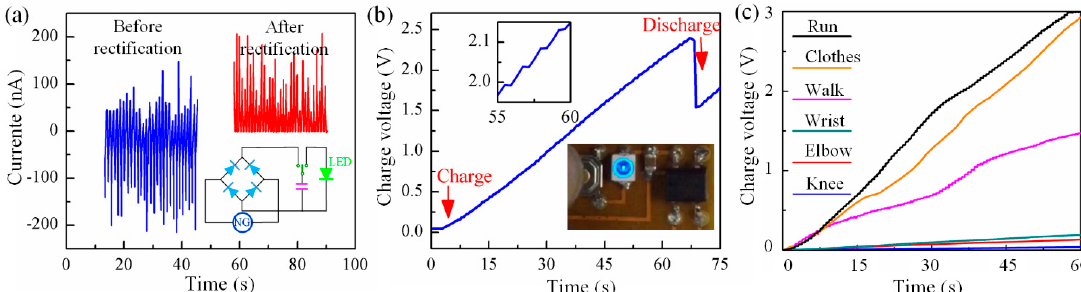
Figure 6. ( a ) Electrical output for energy harvester before and after rectification; ( b ) Voltage of a capacitor as a function of time during charging by fractal fibers under cyclic stretching load, and the charging and discharging by a LED lighter; ( c ) The charging rates of various body motions.